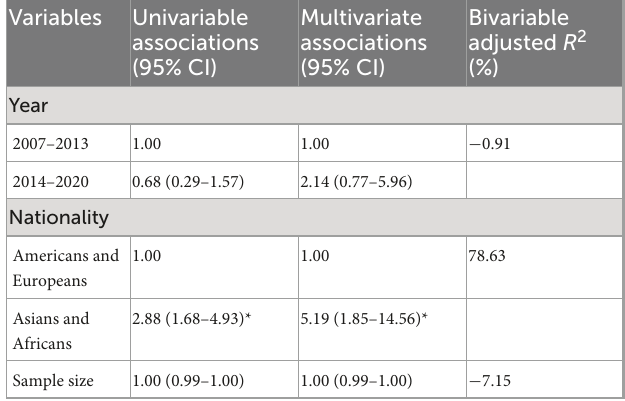
(95% CI = 1.03 to 13.18; I 2 = 98.9%) vs. (Male: 2.53 (95% CI = 1.87 to 3.42; I 2 = 73.1%)] ( Figure 3 ).